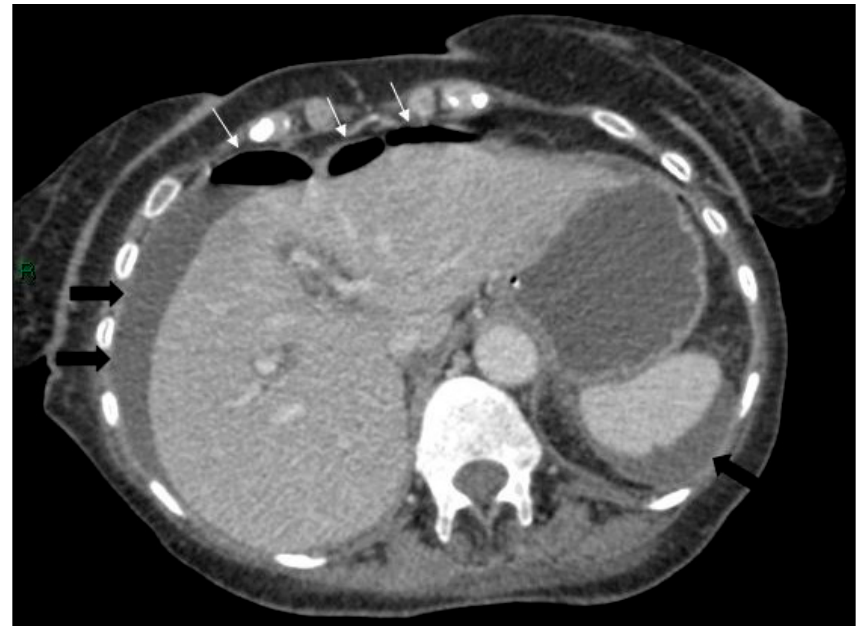
Figure 3. Axial CT scan of the abdomen showing free air anterior to the liver (white arrows) and free fluid around the liver and spleen (black arrows).